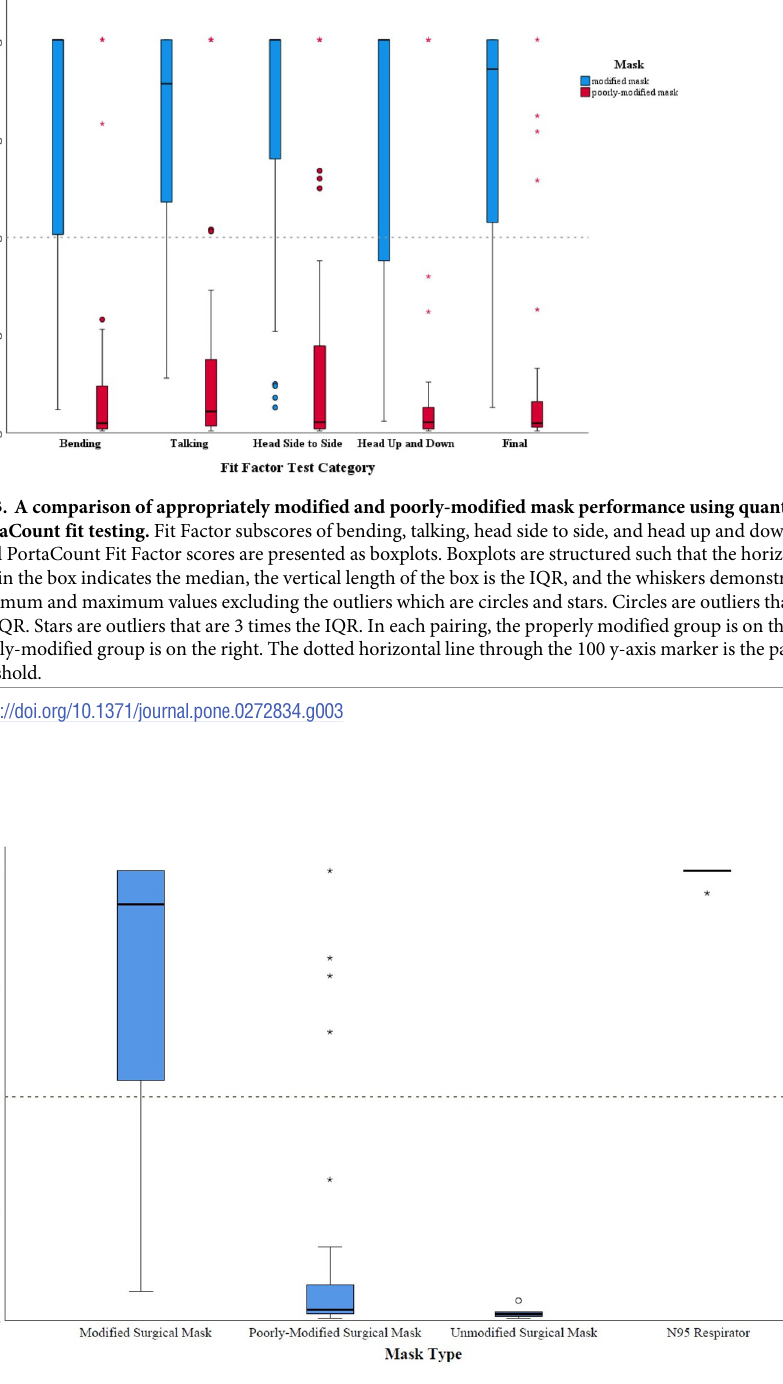
Fig 4. Comparative summative fit performance between appropriately modified, poorly-modified, unmodified surgical masks, and N95 respirators based on quantitative PortaCount testing. Boxplots demonstrate the horizontal line within the box as the median, the vertical length of the box as the IQR, and the whiskers as the minimum and maximum values excluding outliers which are circles and stars. Circles are outliers that are 1.5 times the IQR. Stars are outliers that are 3 times the IQR. The dotted horizontal line through the 100 y-axis marker is the passing threshold.